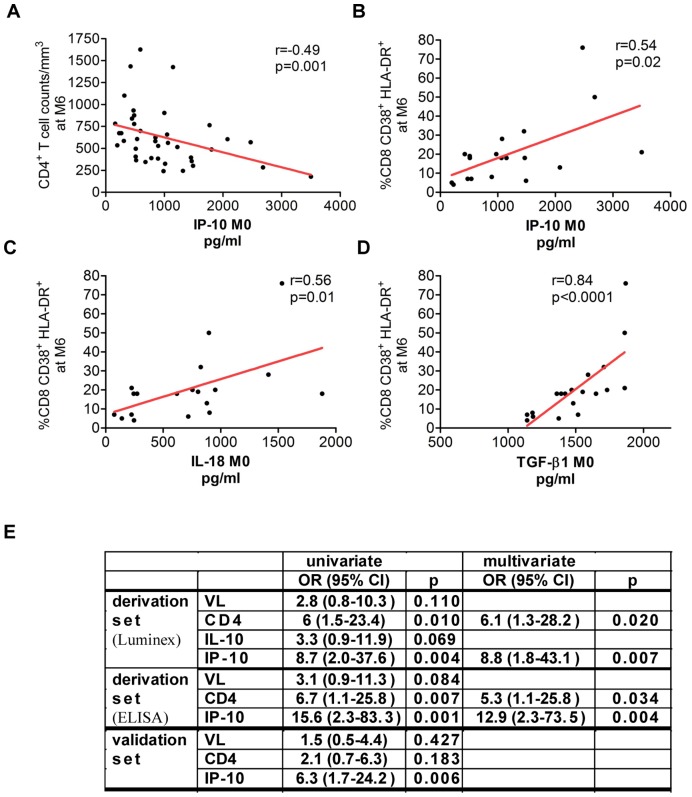
Cytokines predictive of immunological set-point levels. (A–E)Cytokine concentrations in plasma at M0 have been plotted against CD4+ T cell counts and T cell activation (CD3+CD8+CD38+HLA-DR+) at M6. Six patients, including 4 who were treated at M6, were excluded from the analysis at M6. T cell activation levels were available for 19 patients at M6 (4 SP, 7 SP, 8 RP). The correlations were thus analyzed in 40 patients regarding CD4+ T cell counts and viral load and for 19 patients regarding T cell activation. (A) IP-10 levels at M0 plotted against T CD4+ counts at M6. (B) IP-10 levels at M0 plotted against T cell activation at M6. (C) IL-18 levels at M0 plotted against T cell activation at M6. (D) TGF-β1 concentrations at M0 plotted against T cell activation at M6. The red line indicates that both the Spearman correlation and the linear regression analysis were significant. (E) Regression analysis for evaluation of the capacity of CD4+ T cell counts, VL and cytokines at M0 to predict rapid disease progression. Values obtained for both the derivation set (Luminex and ELISA) and the validation set are shown. Median values of CD4+ T cell counts, VL and cytokine levels were used: VL > = 5 log; CD4<570 cells (derivation set); CD4<546 cells (validation set); IP-10> = 869 pg/ml (derivation set, Luminex); IP-10> = 247 pg/ml (derivation set, ELISA); IP-10> = 232 pg/ml (validation set, ELISA).